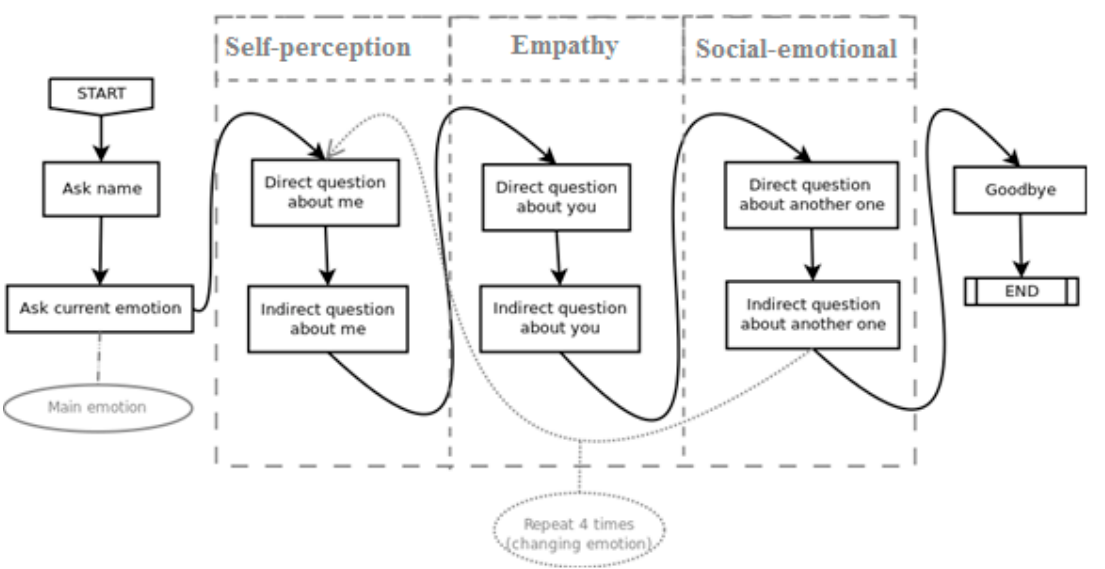
Figure 4. Dialogue flow, where the system goes between direct and indirect questions, and first, second, and third person. This cycle is repeated a total of 4 times in order to explore the four basic emotions (happiness, sadness, anger, and fear).